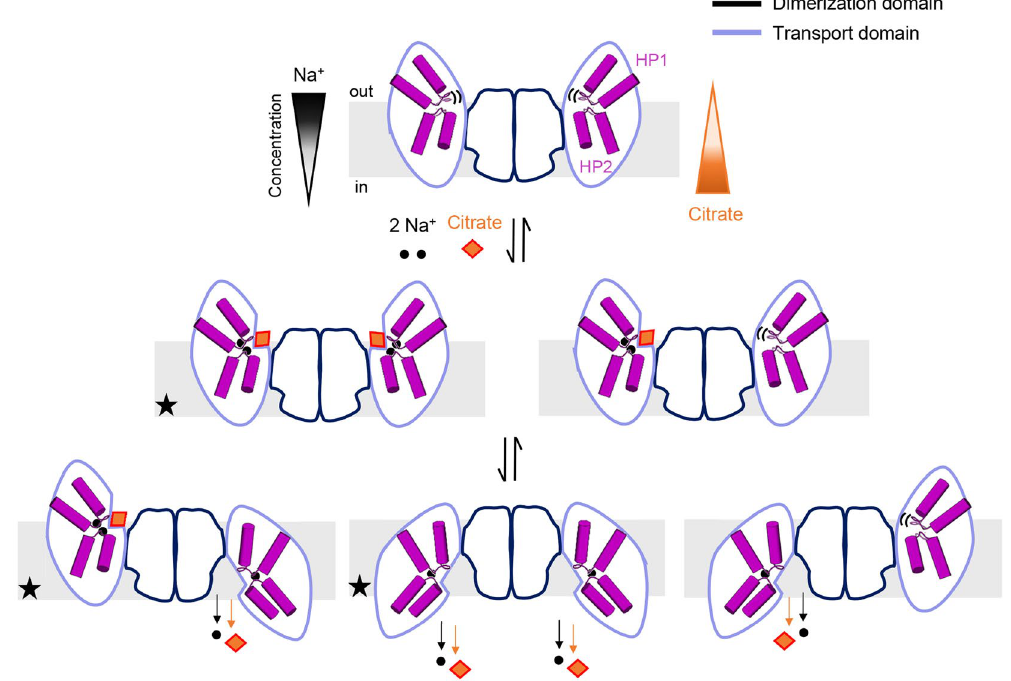
Figure 7. Proposed transport mechanism of the CitS. Dimerization and transport domains are shown in dark and pale blue, respectively. The helical hairpins, HP1 and HP2, of the transport domain are represented as cylinders and loops in purple. Citrate is shown as an orange diamond, and sodium ions as black spheres. In the apo state, the binding site of substrate and ions is open toward the external environment. Binding of sodium ions prepares the protein to interact with its substrate, which promotes the elevator-like movement of the transport domain in either one of two protomers in the dimer or both. Dissociation of citrate and ions into the cytoplasm resets the protein into the outward-facing apo state. The crystal structures of CitS that have been determined by us and others 22 are marked with black